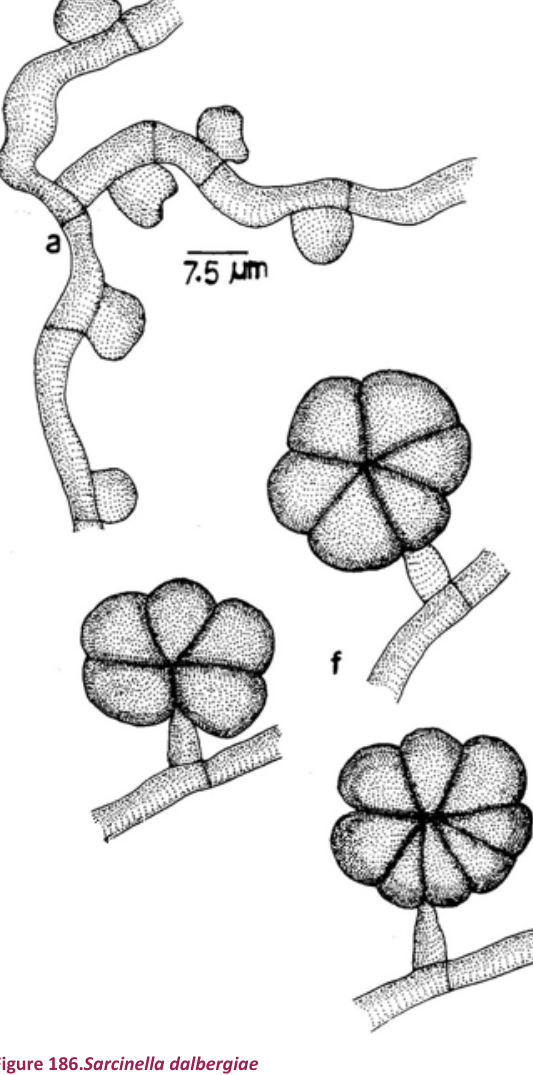
Figure 186. Sarcinella dalbergiae a - Appressoriate mycelium; f - Sarciniform conidia